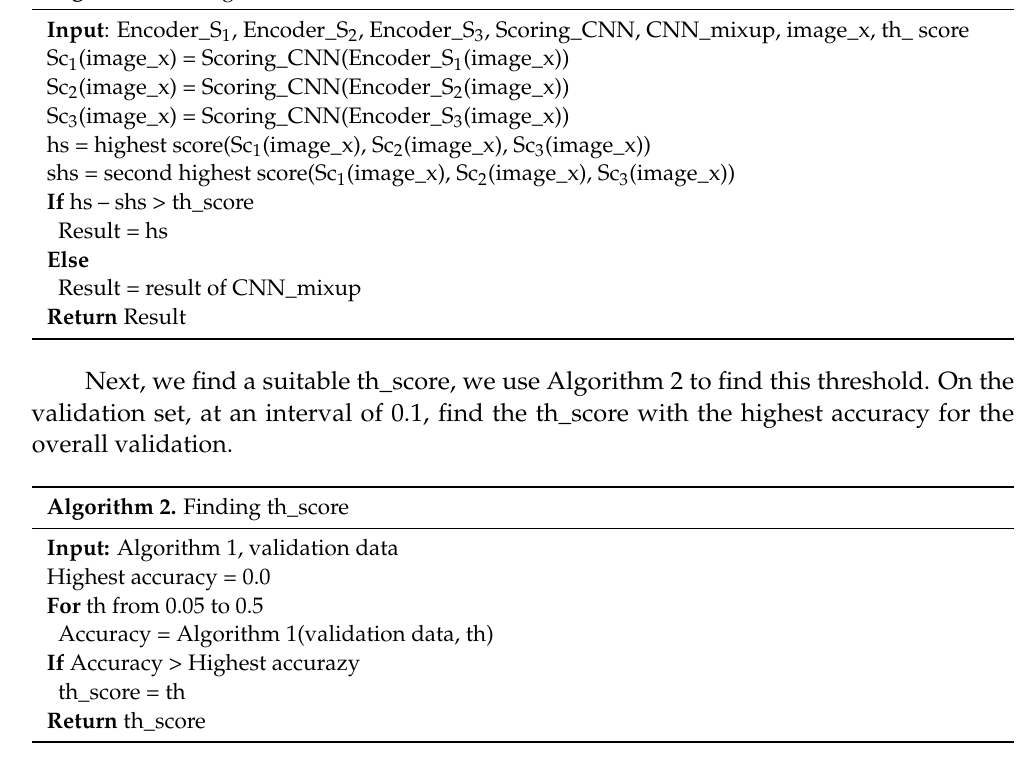
Algorithm 1. Integration 2 model